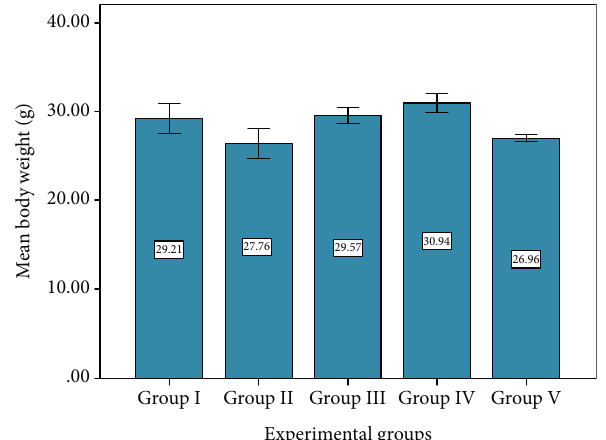
Figure 5: Body weight of experimental mice (DMBA-induced mice signi fi cantly ( p < 0 : 05 ) reduced the body weight; FA-treated mice signi fi cantly ( p < 0 : 05 ) increased the body